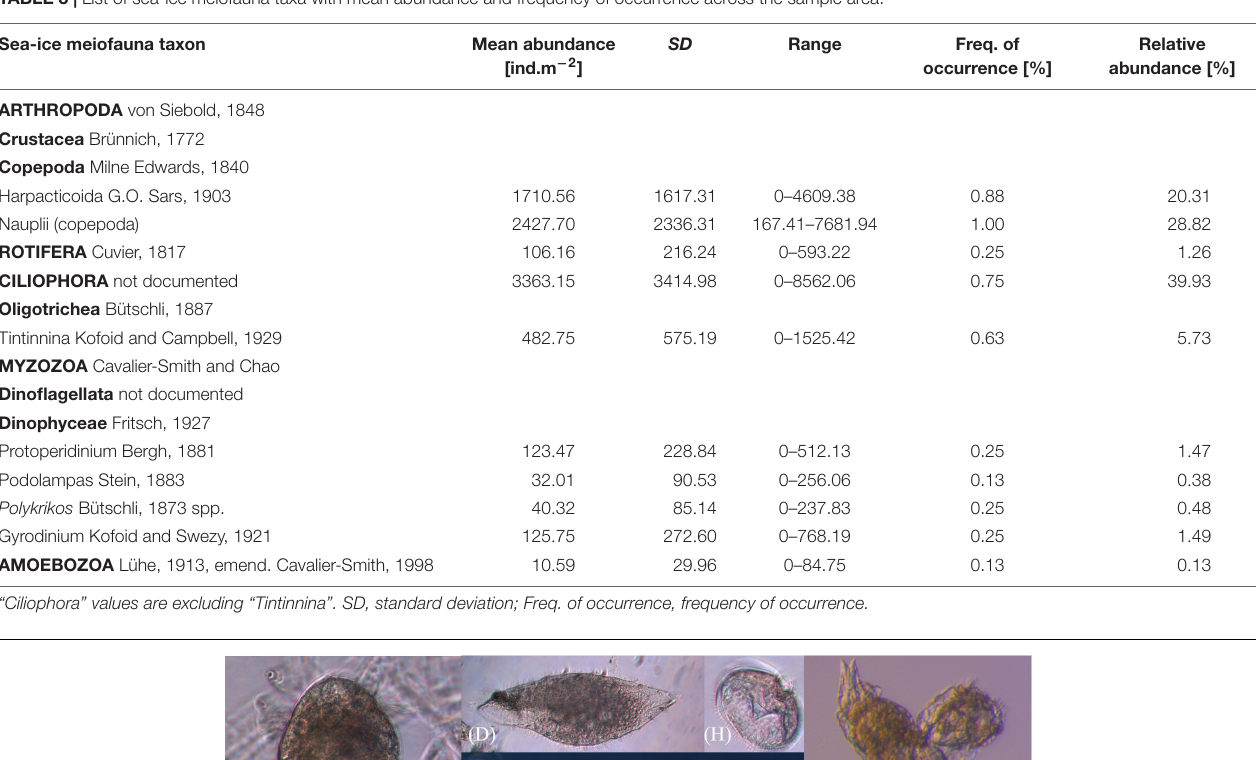
abundance ( Table 3 ). The community structure showed some geographical or seasonal/temporal variability, since Rotifera, Dinophyceae, and Amoebozoa occurred solely at the four easternmost stations (stations 19–32) on the shelf of Svalbard